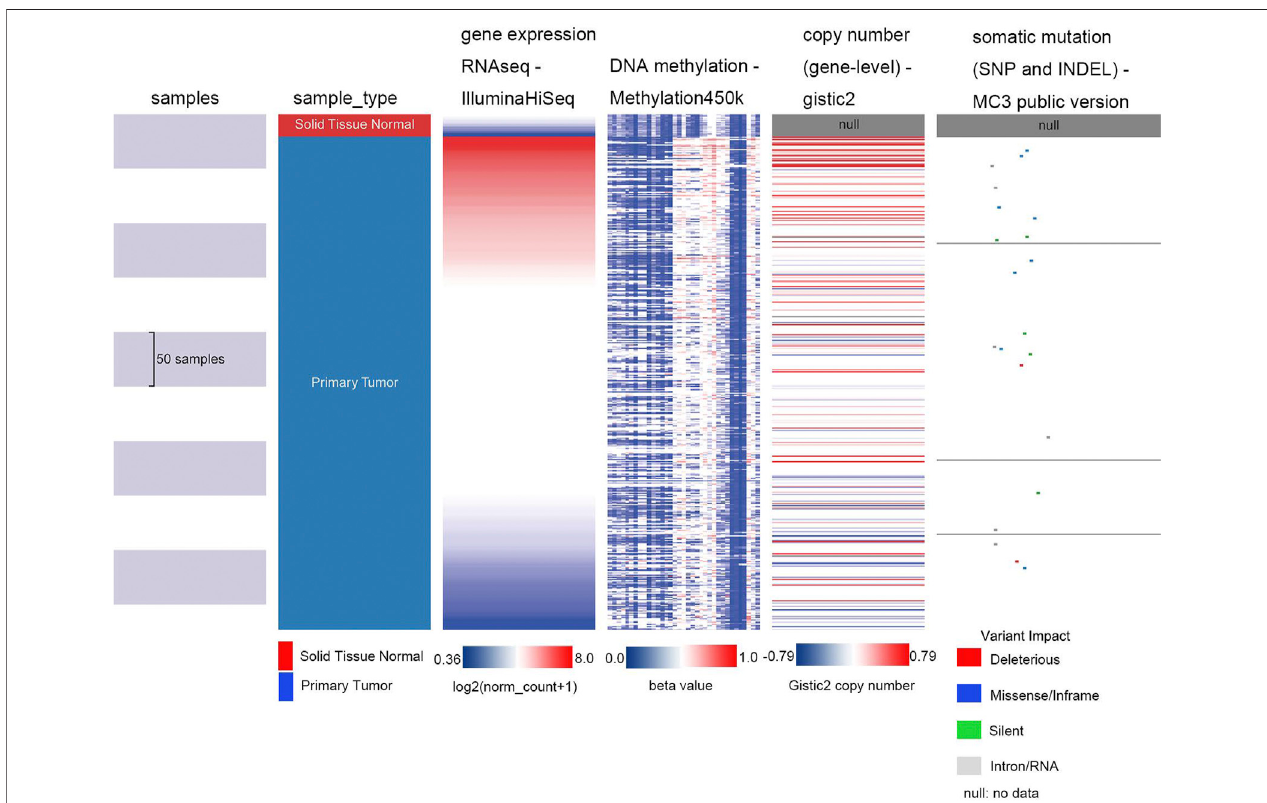
FIGURE 5 | Heat map of SHOX2 mRNA expression, methylation, copy number, and somatic mutation in patients with primary LUAD and normal tissue. The data are obtained from TCGA-LUAD with a total of 706 samples. LUAD: lung adenocarcinoma.